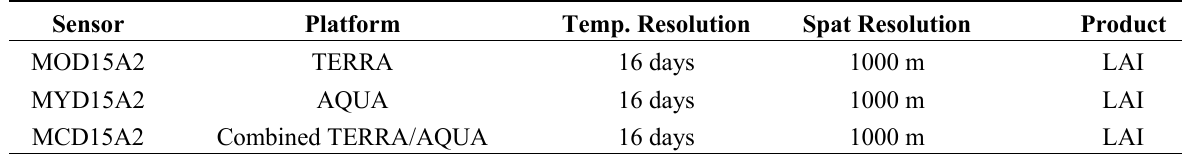
Table 2. MODIS products and corresponding spectral